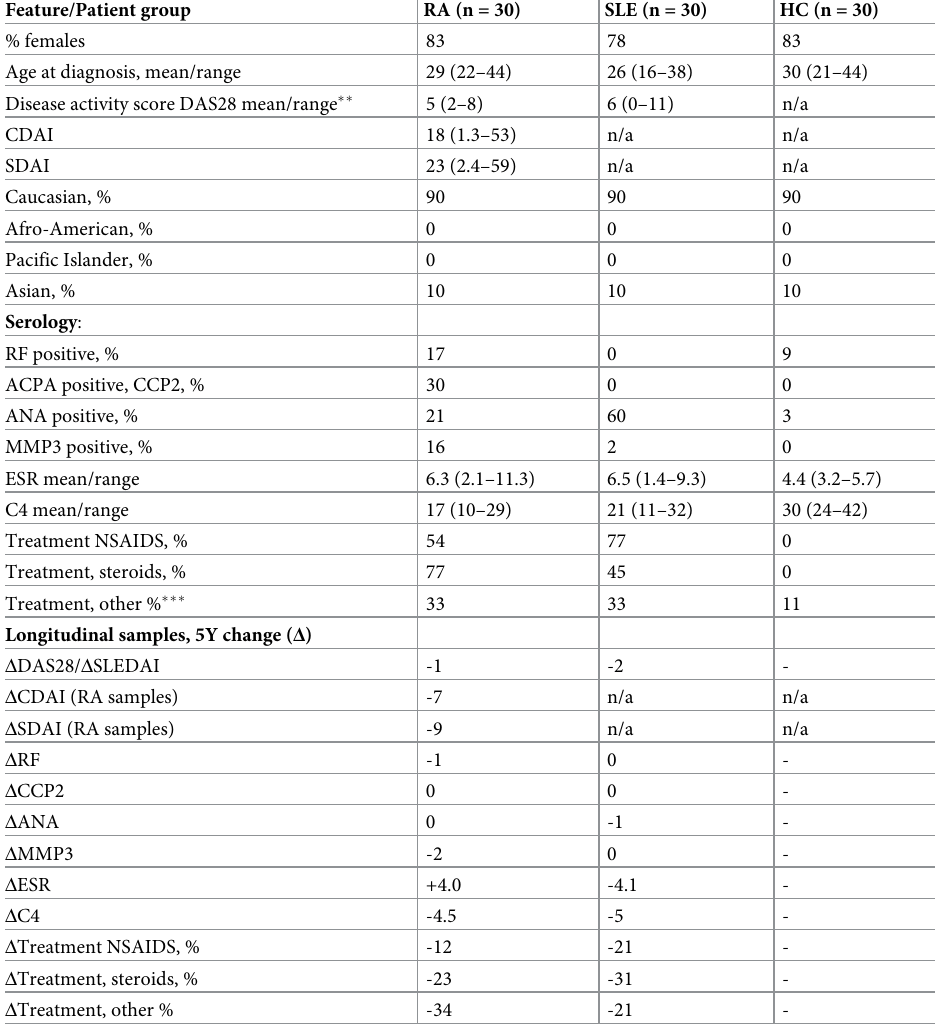
�� Disease activity (DAS28 and SLEDAI for RA and SLE, respectively) scores have been applied. Besides, CDAI (clinical disease activity index), and SDAI (simplified disease activity index) were applied to RA cohort.